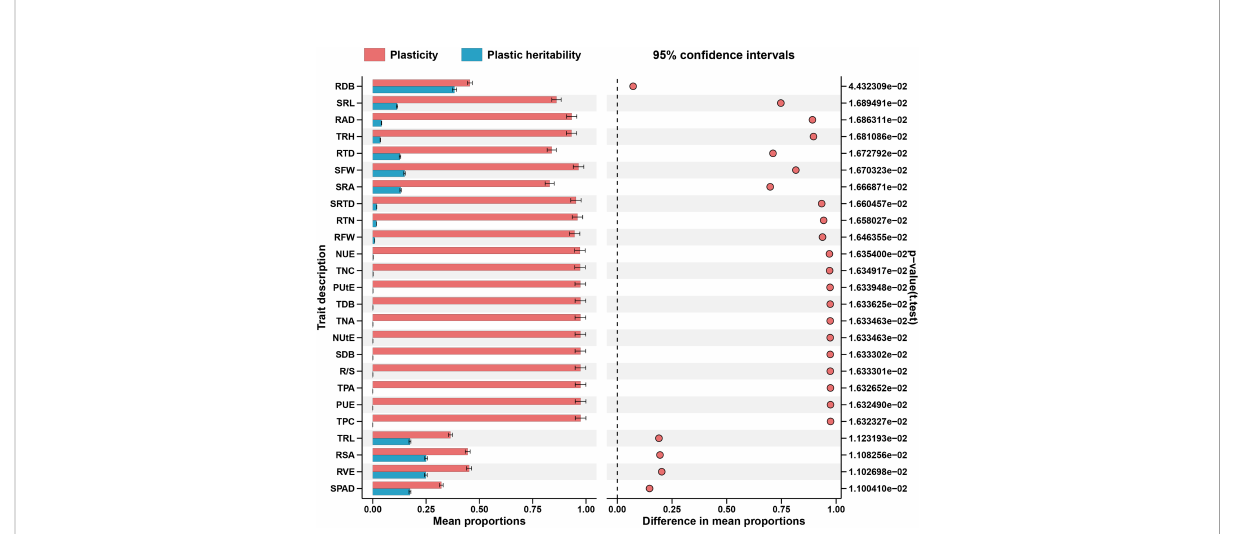
FIGURE 6 Absolute plasticity of the measured traits in response to both P supply. Trait notations: shoot dry biomass (SDB), root dry biomass (RDB), total dry biomass (TDB), taproot length (TRL), root surface area (RSA), root volume (RVE), total root length(TRH), root average diameter (RAD), speci fi c root length (SRL), speci fi c root area (SRA), root tissue density (RTD), root tips number (RTN), speci fi c root tips density (SRTD), shoot fresh weight (SFW), root fresh weight (RFW), root shoot ratio (R/S), SPAD value (SPAD), total phosphorus concentration (TPC), total phosphorus accumulation (TPA), phosphorus use ef fi ciency (PUE), phosphorus uptake ef fi ciency (PUtE), total nitrogen concentration (TNC), total nitrogen accumulation (TNA), nitrogen use ef fi ciency (NUE), nitrogen uptake ef fi ciency (NUtE). Error bars are standard errors of the mean (n =